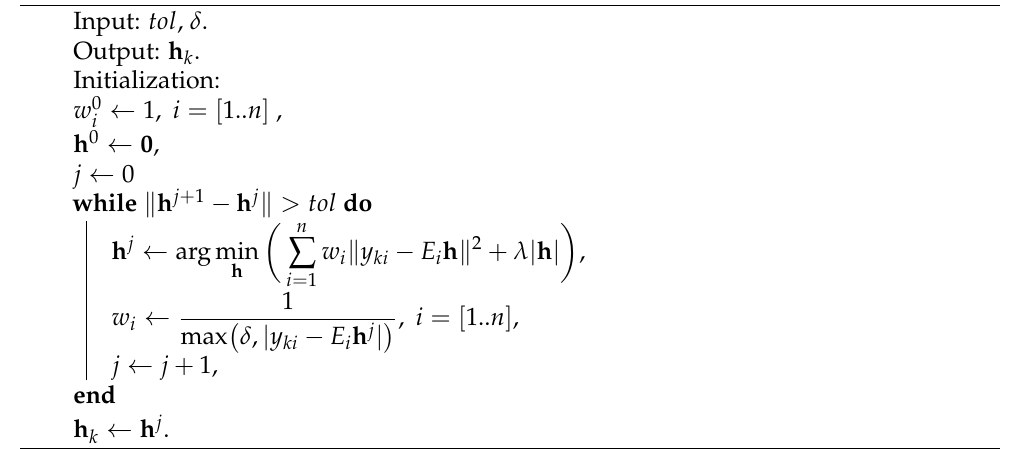
Algorithm 1: Iteratively reweighted least squares (IRLS) with (cid:96) 1